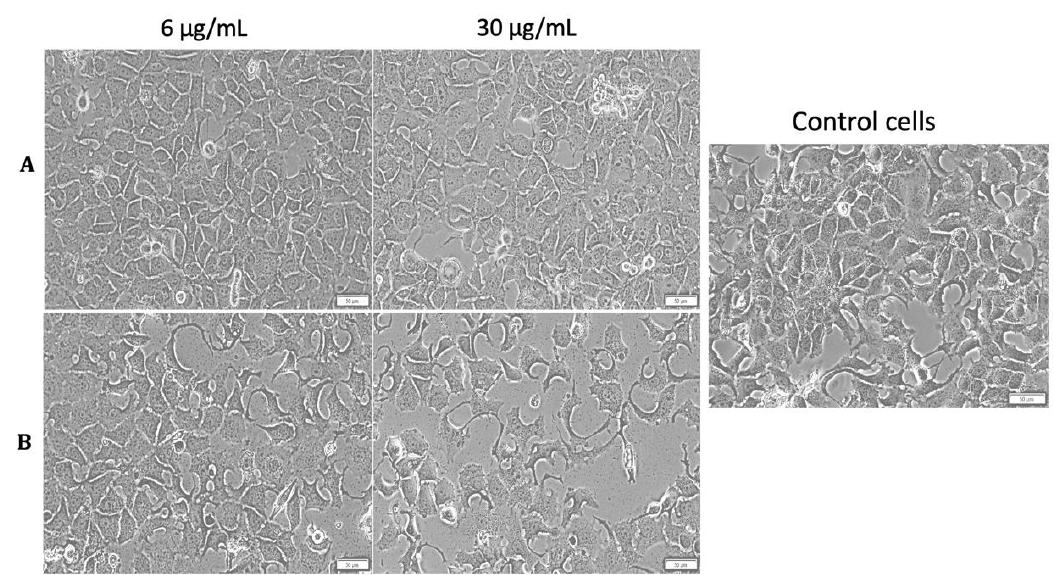
Figure 12. Morphology of MCF-7 cells after treatment with MCS under standard ( A ) and hyperthermic conditions ( B ). Phase contrast pictures were taken 24 h post-incubation at a magnification of 20×. Scale bars represent 50 µm.